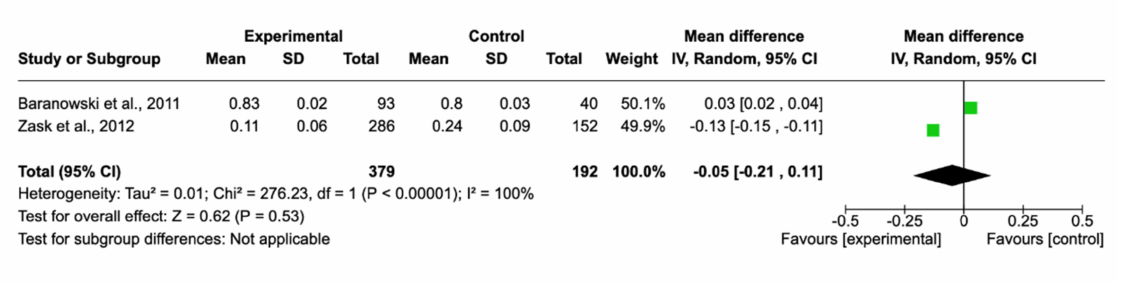
Figure 3. Forest plot for body mass index